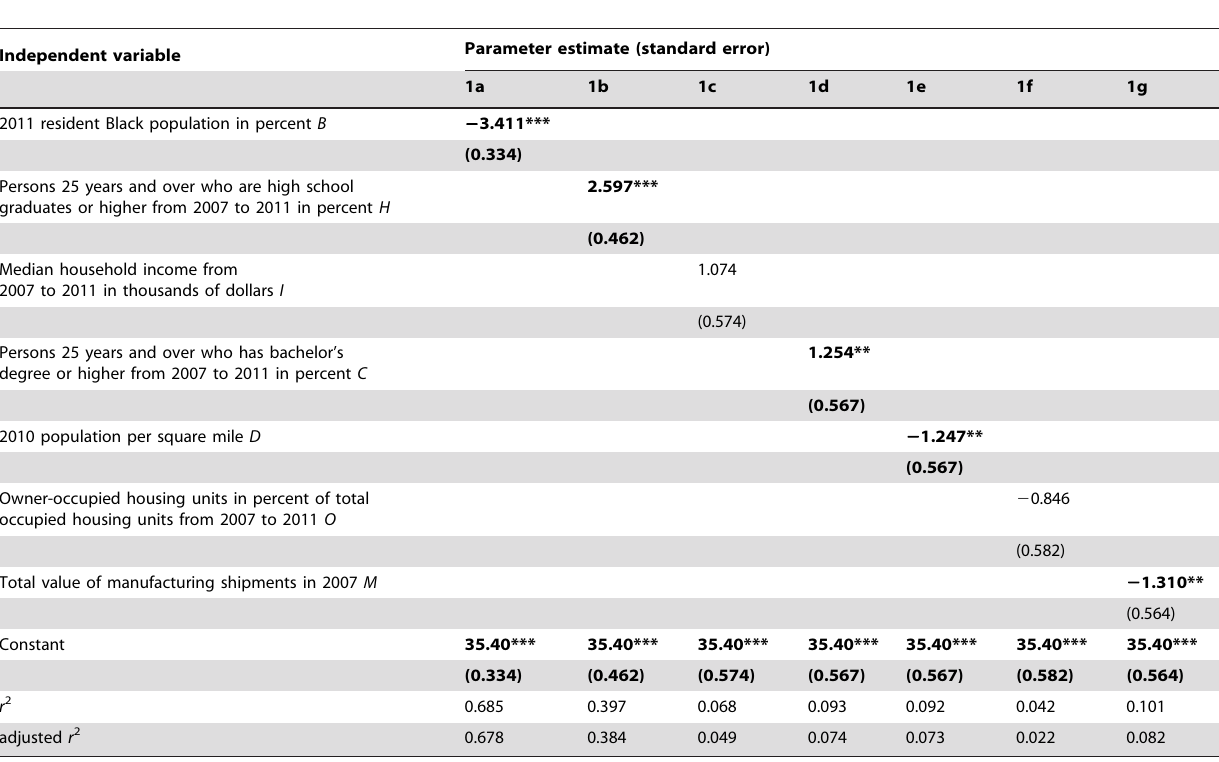
Table 2. Single-variable linear regression of median utterance length with selected US Census Bureau QuickFacts variables.